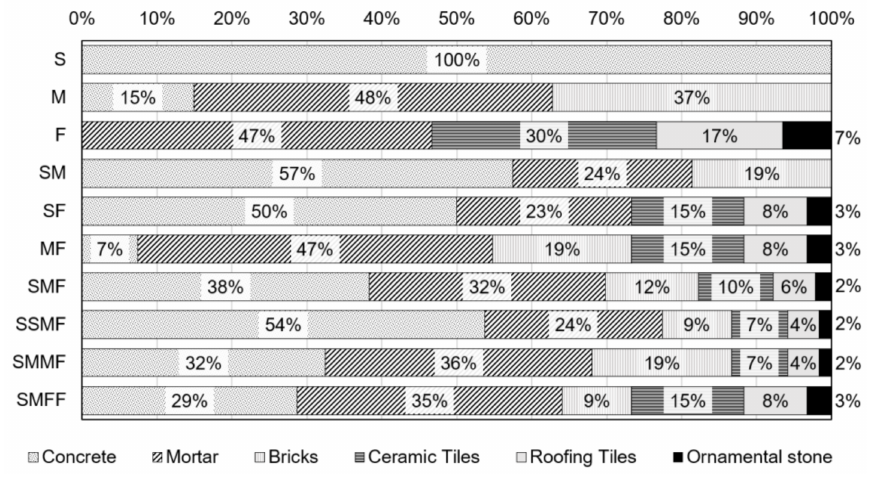
Figure 7. Gravimetric composition of the processed